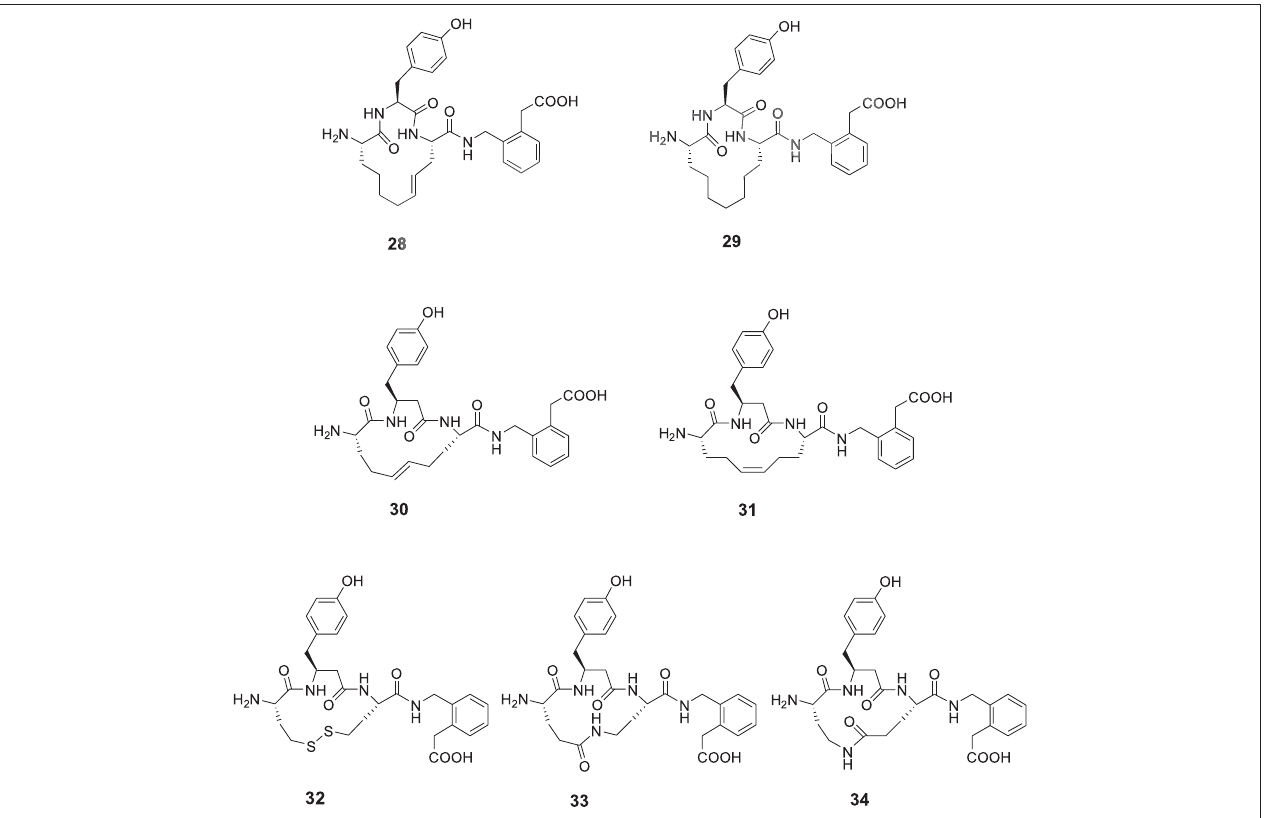
Figure7| MacrocyclizationsintheN-terminal.AcomparisonoftheactivityofaseriesofcyclizedAngIVanaloguesencompassing14-memberedringsystems.The macrocyclic 28 and 30 , made by metathesis reactions are the most potent IRAP inhibitors in the series and somewhat more potent than the disul fi de analogue 32 . Compound 29 with a saturated carbon bridge and the cis isomer 31 are 10-fold less potent and the amides 33 and 34 more than 100-fold less potent than the most effective IRAP inhibitor compound 30 .